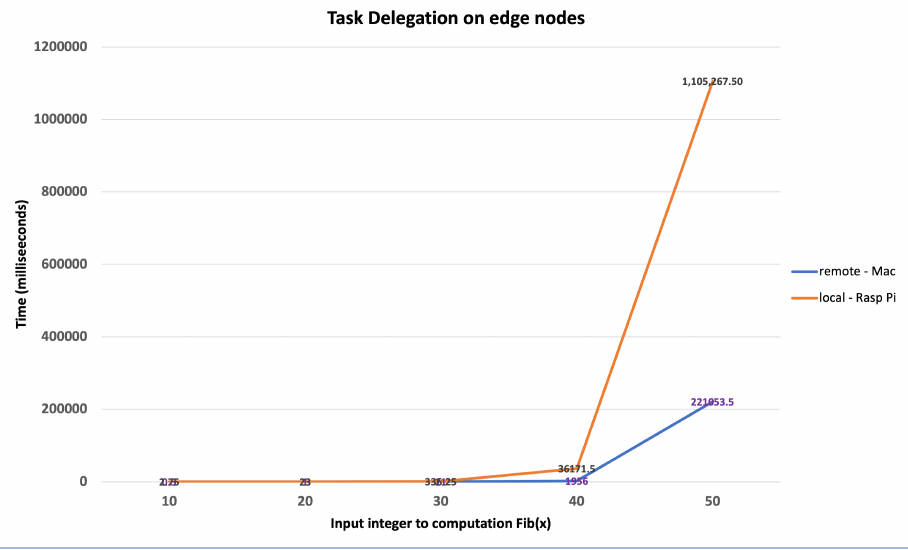
Figure 21. Computational Task